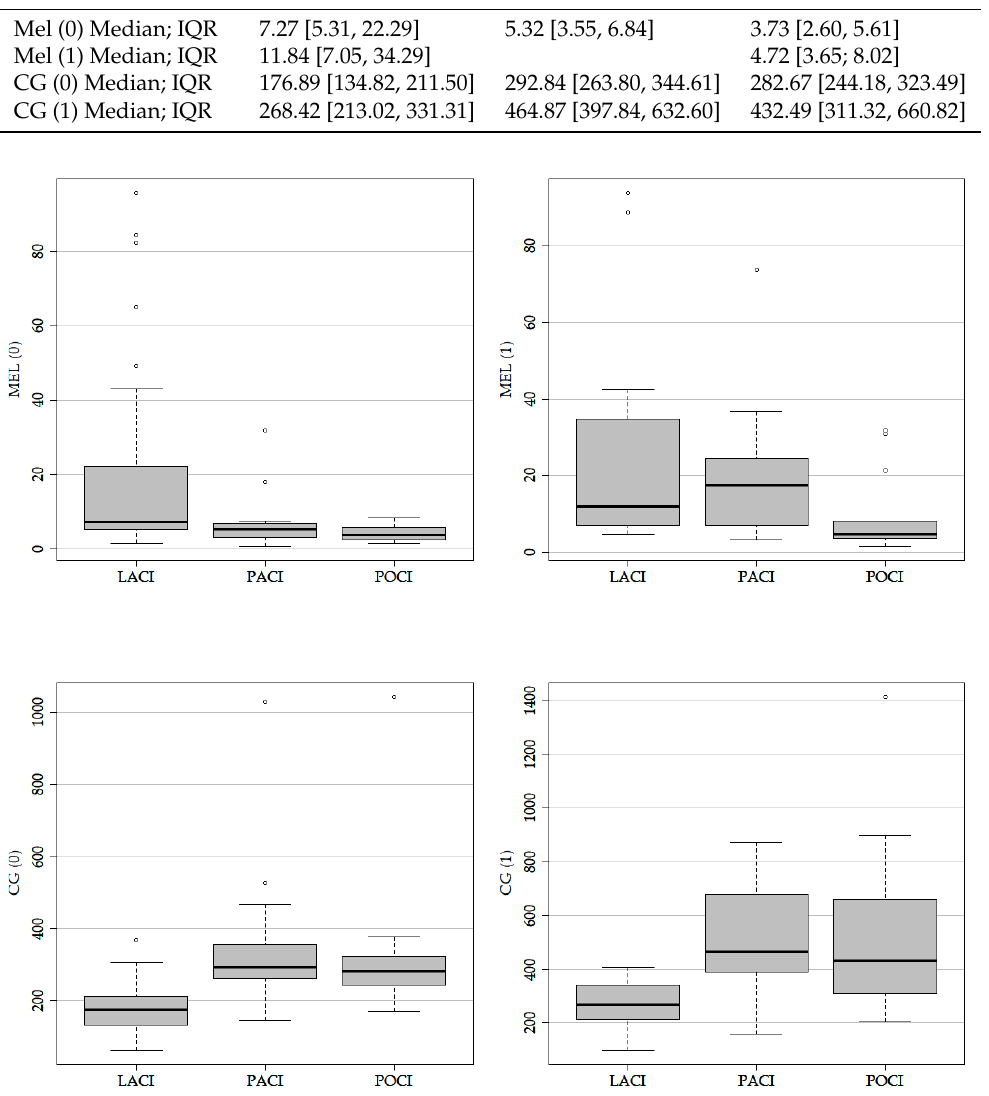
Figure 3. Oxidative stress biomarkers by subtypes of